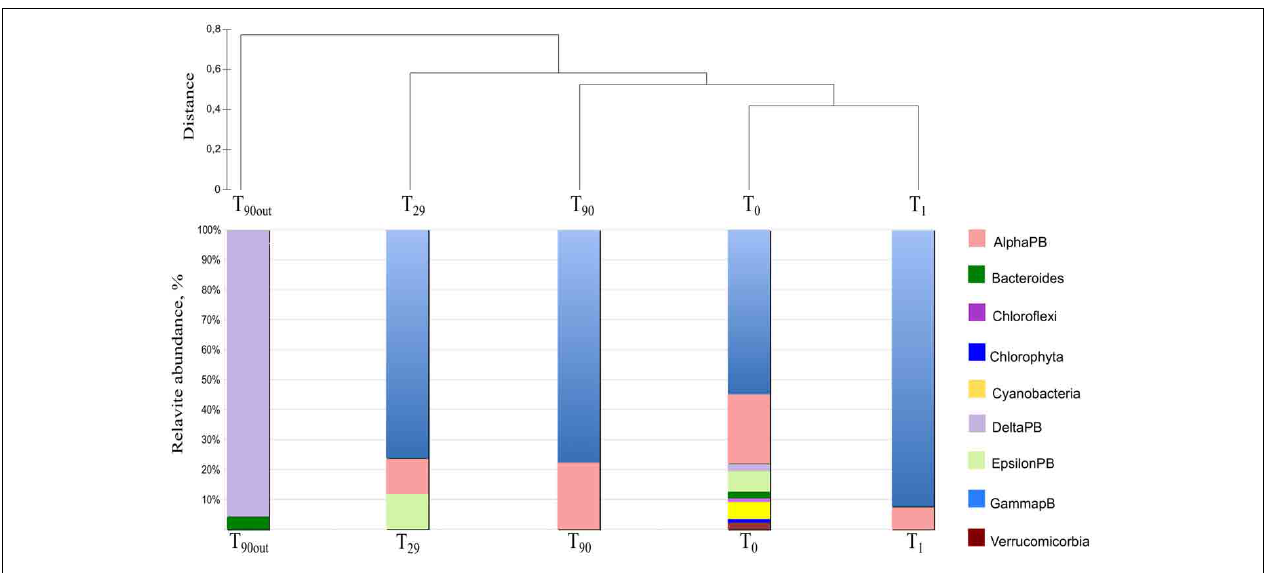
FIGURE 9 | Dendrogram of microbial biodiveristy and similarity analysis of the 16S rRNA transcripts detected at different sampling time and treatment. The UPGMA cluster analysis was